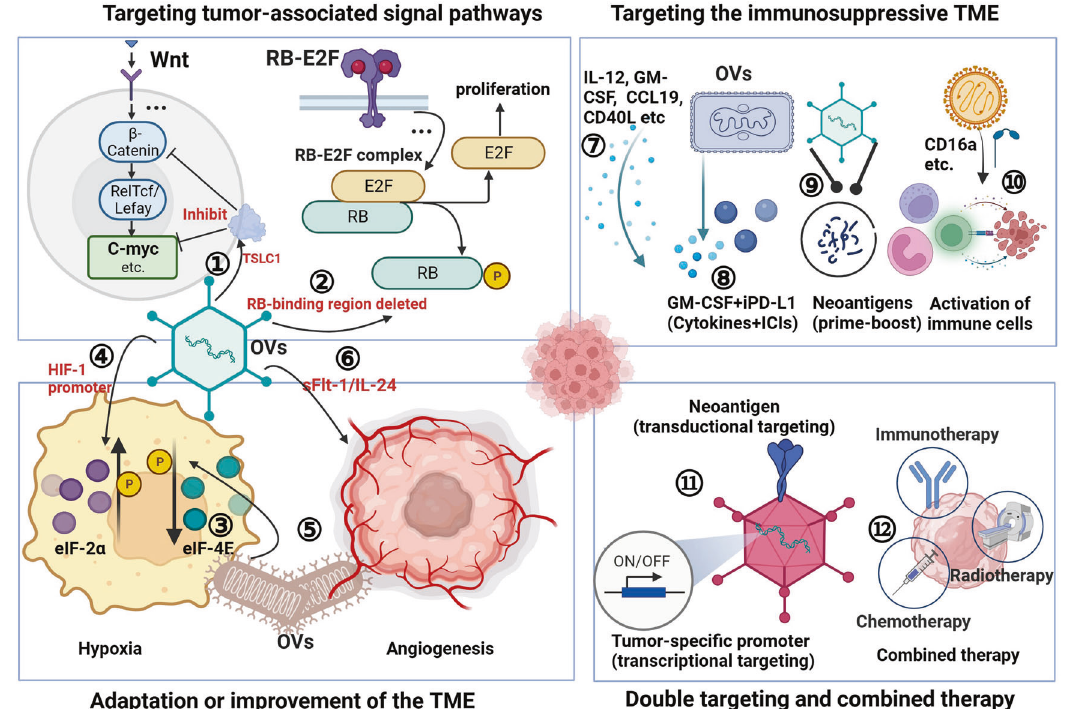
Fig. 2 Mechanism for targeting and oncolysis of OVs. Oncolytic viruses (OVs) target dysfunctional signaling pathways. (1) Targeting the Wnt signaling pathway, recombinant adenovirus express lung cancer suppressor-1 (TSLC1), acts by downregulating the transcriptional activity of Tcf4/ β catenin and inhibiting the expression of CyclinD1 and C-myc, thereby killing Wnt abnormally activated liver cancer cells. (2) E1A(922- 947) deleted AdVs replicate and lyse tumor cells. OVs targeting for the adaptation or improvement of the tumor microenvironment (TME) of the tumor. (3) VSV replicates under hypoxic conditions with increased phosphorylated subunits of eIF-2 α and inhibits the translation of host cell proteins through the dephosphorylation of translation initiation factor eIF-4E. (4) The Hypoxia inducible factors (HIFs) promoter was applied in AdV to the delivery target genes under hypoxia. (5) VSV naturally targets vascular endothelial cells and inhibits the growth of tumor cells. (6) Expression of vascular growth factor inhibitors (sFlt-1) and anti-angiogenic cytokine (IL-24) by OVs to inhibit tumor angiogenesis. OVs Targeting immunosuppressive TME. (7) OVs were designed to express a variety of cytokines, chemotactic factors, immune checkpoint inhibitors (ICIs) and neoantigens. (8) OVs simultaneously expressing cytokines (GM-CSF) and ICIs (iPD-L1). (9) Neoantigens encoding OVs and heterologous prime-boost strategy (AdV + MVA) (10) Activation of immune cells for tumor lysis by OVs. (11) Combine tumor-speci fi c promoter- derived transcriptional targeting with transductional targeting (through viral capsid incorporation of anti-human carcinoembryonic antigen single variable domains). (12) Combined OV therapy with chemotherapy, radiotherapy and other immunotherapies, etc. (Created in